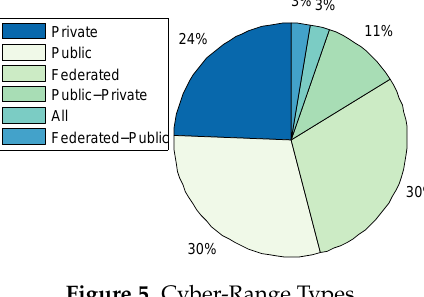
Figure 5. Cyber-Range